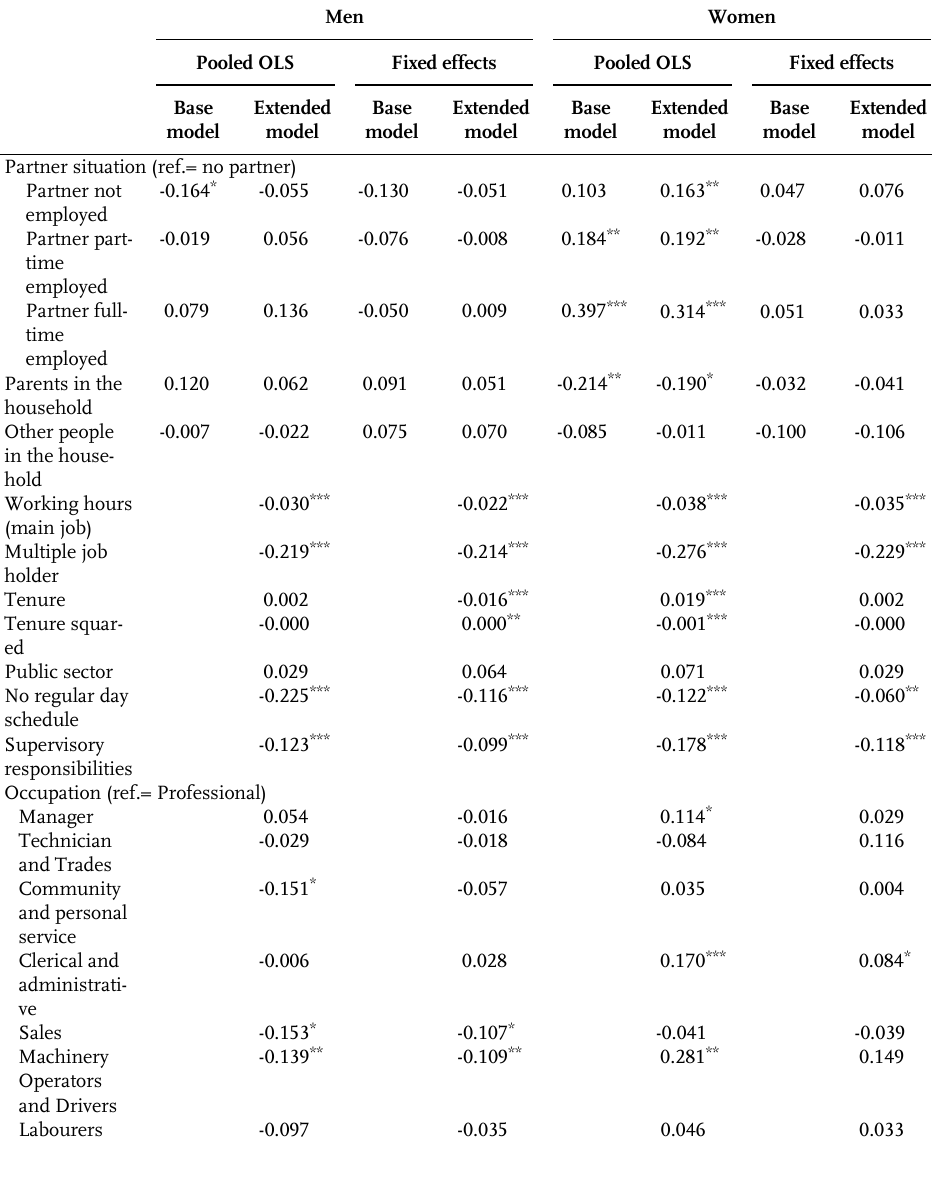
Table A.4 : Employment types and WFC (reflected scale) of parents with children aged 17 and younger (full models)